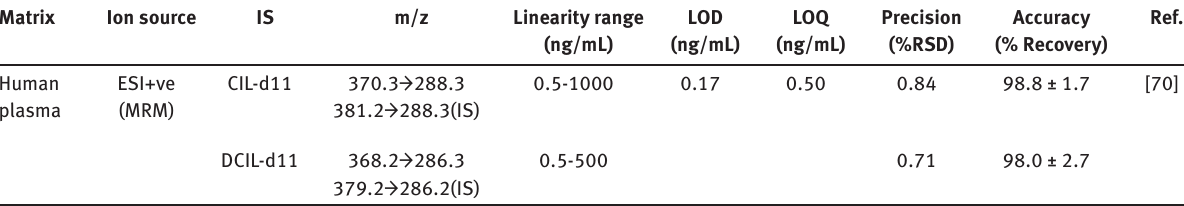
ESI+ : electrospray ionization positive